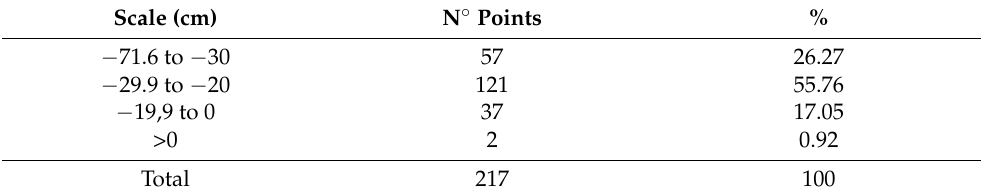
Table 5. Scale referring to the altimetric difference between the first and the last collection.